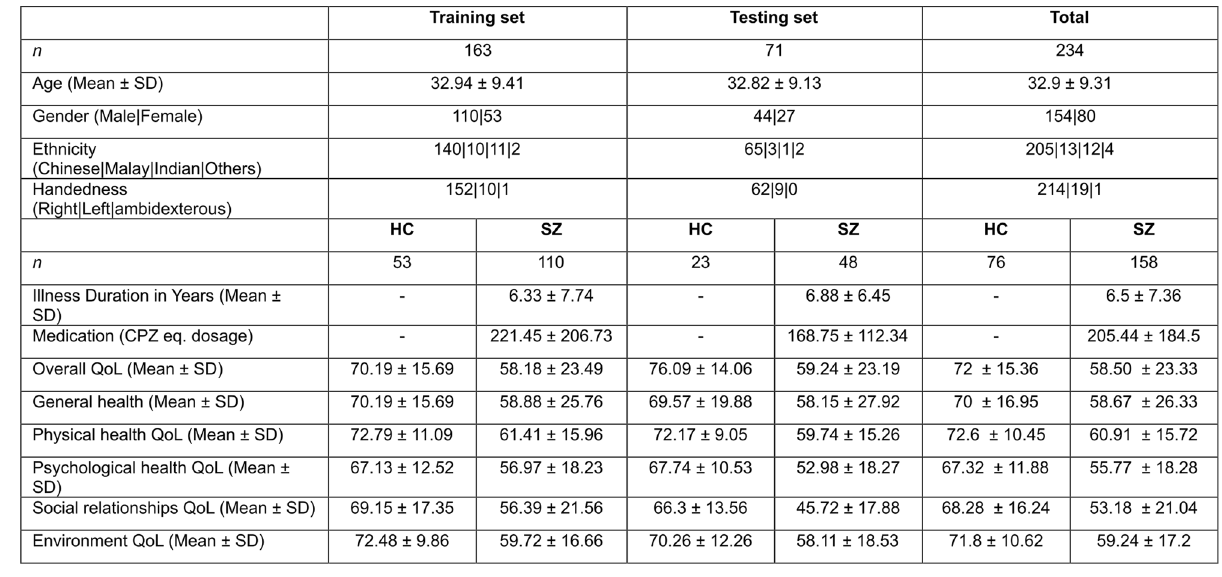
Figure 3. Demographics of patients and controls in training and test datasets.